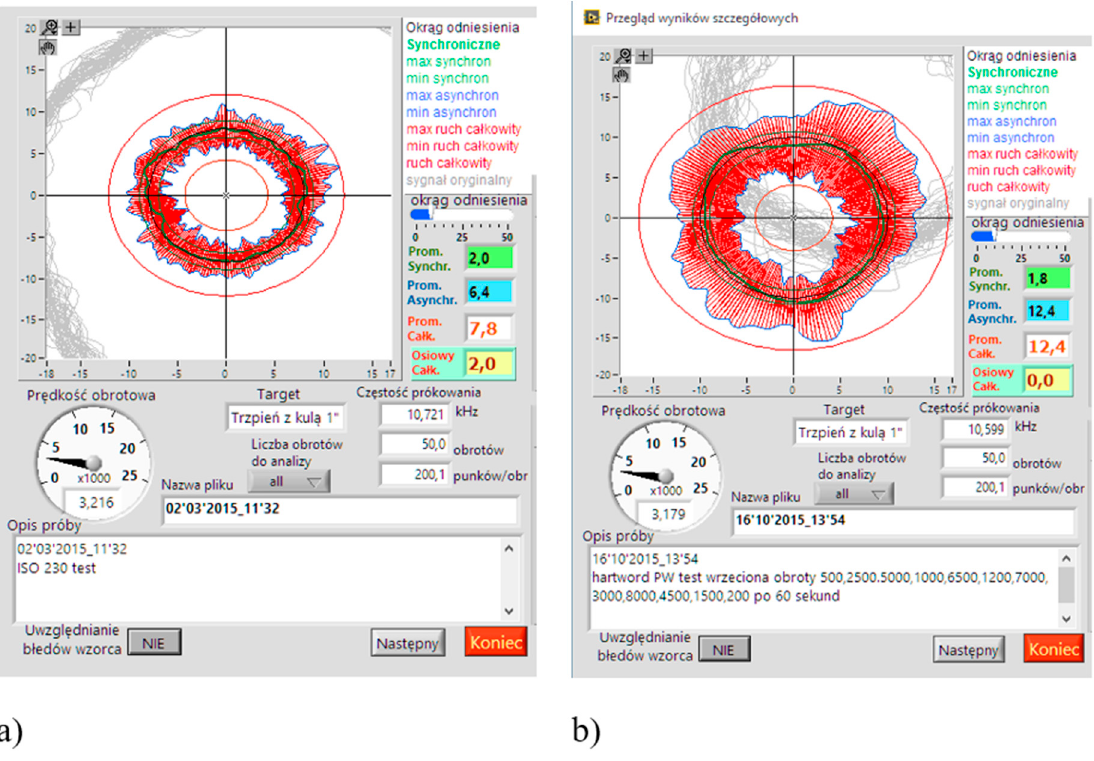
Figure 73. Polar diagrams for the spindle rotational speed of 3200 min − 1 : ( a ) a machine tool working sporadically and ( b ) used intensively.